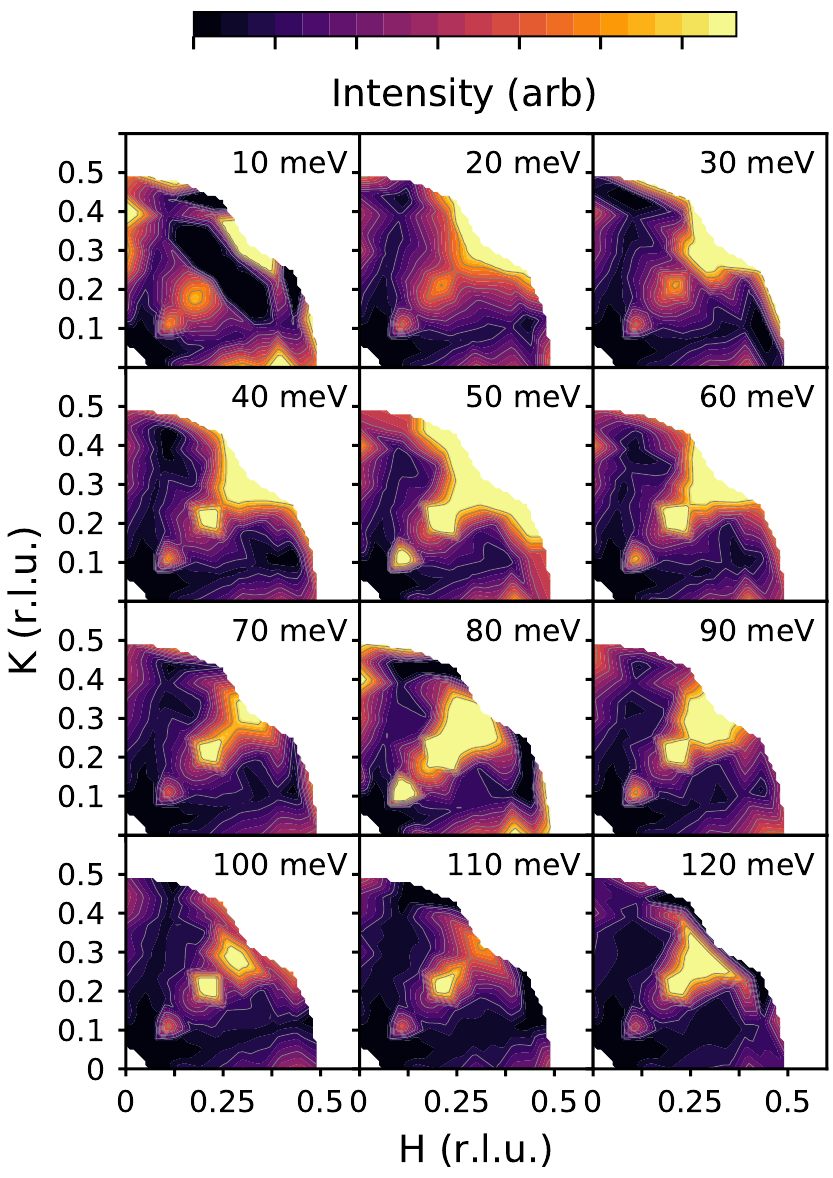
Figure 7: Fixed-energy momentum cuts of χ (cid:48)(cid:48) ( q , ω ) at T = 20 K for different values of ω . The data have been multiplied by q 2 to improve the visibility of high-momentum features.